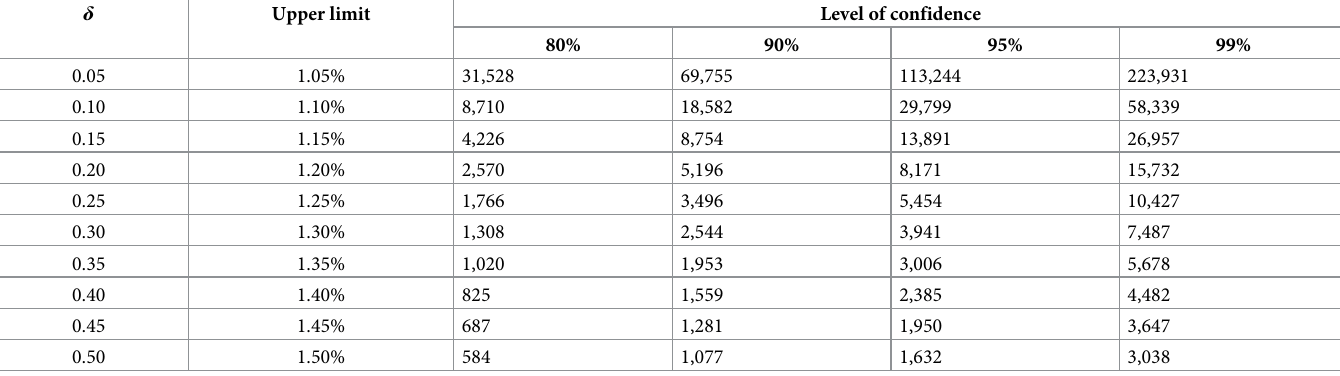
Table 5. Sample size required in order to obtain an expected upper limit of a one-sided exact confidence interval estimate equal to the given values, for a range of confidence levels, assuming the true probability of an adverse outcome = 0.01 (i.e.,